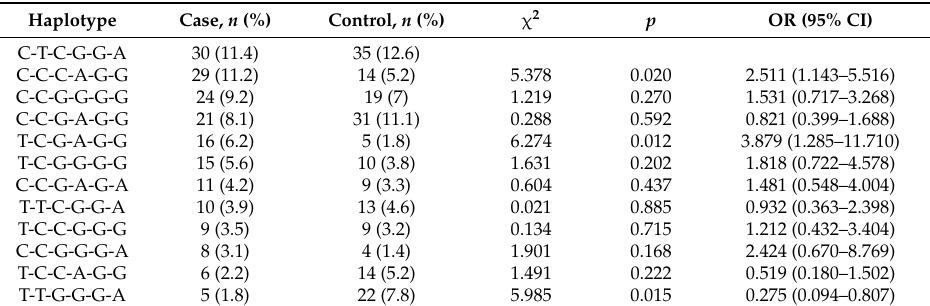
Table 6. Estimated haplotype frequencies of six SNPs in ABCA1 between overweight/obese group and normal weight